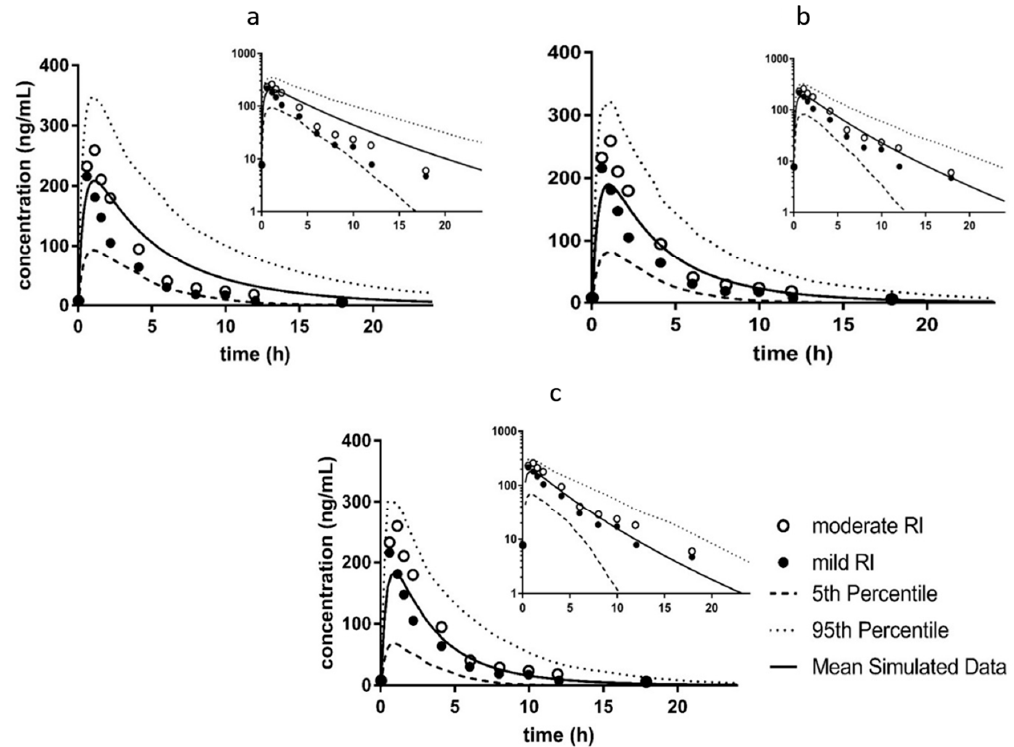
Figure 6. Comparison of Predicted Plasma Profiles for Sildenafil in Renally Impaired Patients for Base and Modified Simulations. Simulations were performed with oral administration of 50 mg of sildenafil to men in a fasted state, age 18–70, the duration of the simulation was 48 h. These conditions are consistent with the parameters of the clinical study from which the observed data was obtained [26]. Simulations were performed with ten trials with ten subjects in each trial. Graphs represent that data on a linear scale, with the inset graphs representing the same data on a log scale. Open circles are observed mild RI data (GFR 50–80 mL/min), closed circles are observed moderate RI data (GFR 30–50 mL/min), solid lines are the mean of the simulation, the dotted line is the 95 th percentile, and the dashed lines are the 5 th percentile. ( a ) Base Simulation—Sim GFR 30_60—simulation performed with the base moderate RI population and base sildenafil compound file; ( b ) Modified Simulation with original CYP expression— f u +5% CYP2C9 R1 CYP3A4 R1—simulation performed with a 5% increase in f u for sildenafil, and competitive inhibition of CYP2C9 and CYP3A4 with a R ([I]/K i ) values of 1 for both enzymes; ( c ) Modified Simulation with modified CYP expression— f u +50% CYP3A4 R10 —simulation performed with a 50% increase in f u for sildenafil and competitive inhibition of CYP3A4 with a R (I/[K i ]) value of 10.